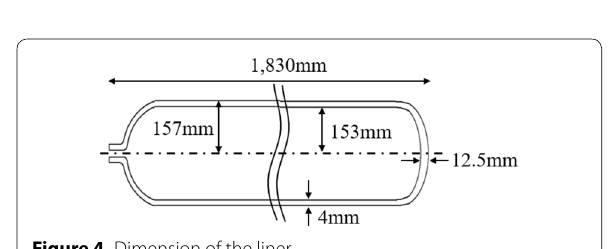
Figure 4 Dimension of the liner